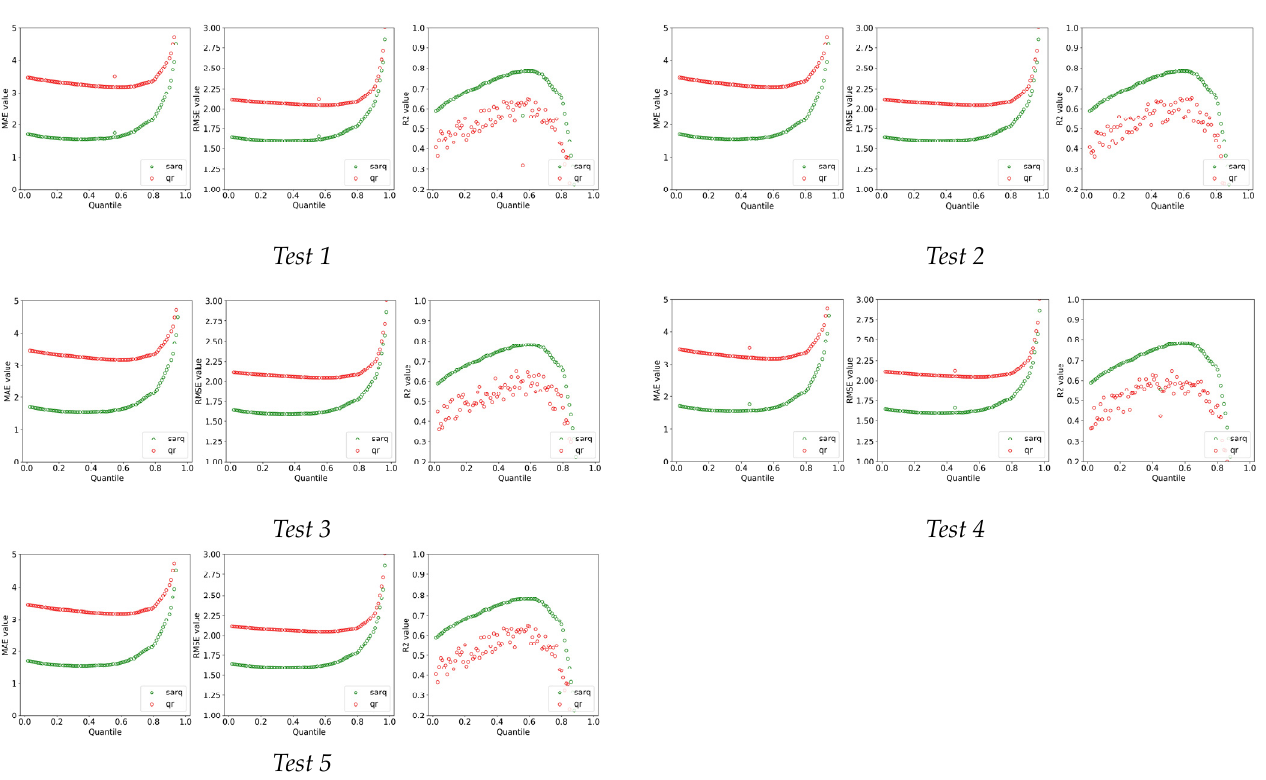
Figure A1. Model performance of total crash rate